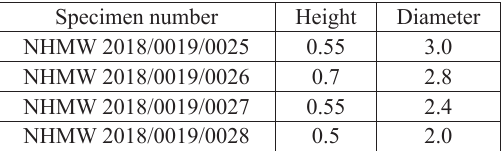
Table 6. Measurements (in mm) of Gyraulus